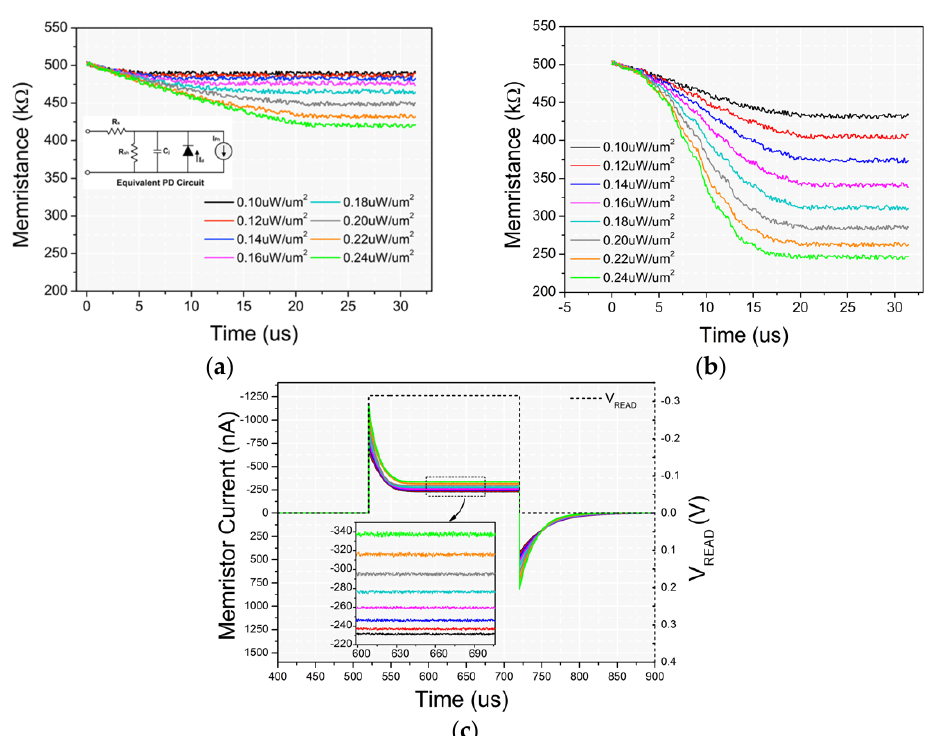
Figure 9. Memristance change as calculated on SPICE simulation for eight PGM operations with eight different light intensities on a single 1D1M element with ( a ) constant V TE bias and ( b ) V TE increment by 0.4 V/three light pulses. ( c ) Memristor currents for eight READ operations of 500 us after the previous eight PGM operations. The inset in ( a ) displays the equivalent PD subcircuit was used in SPICE simulation.